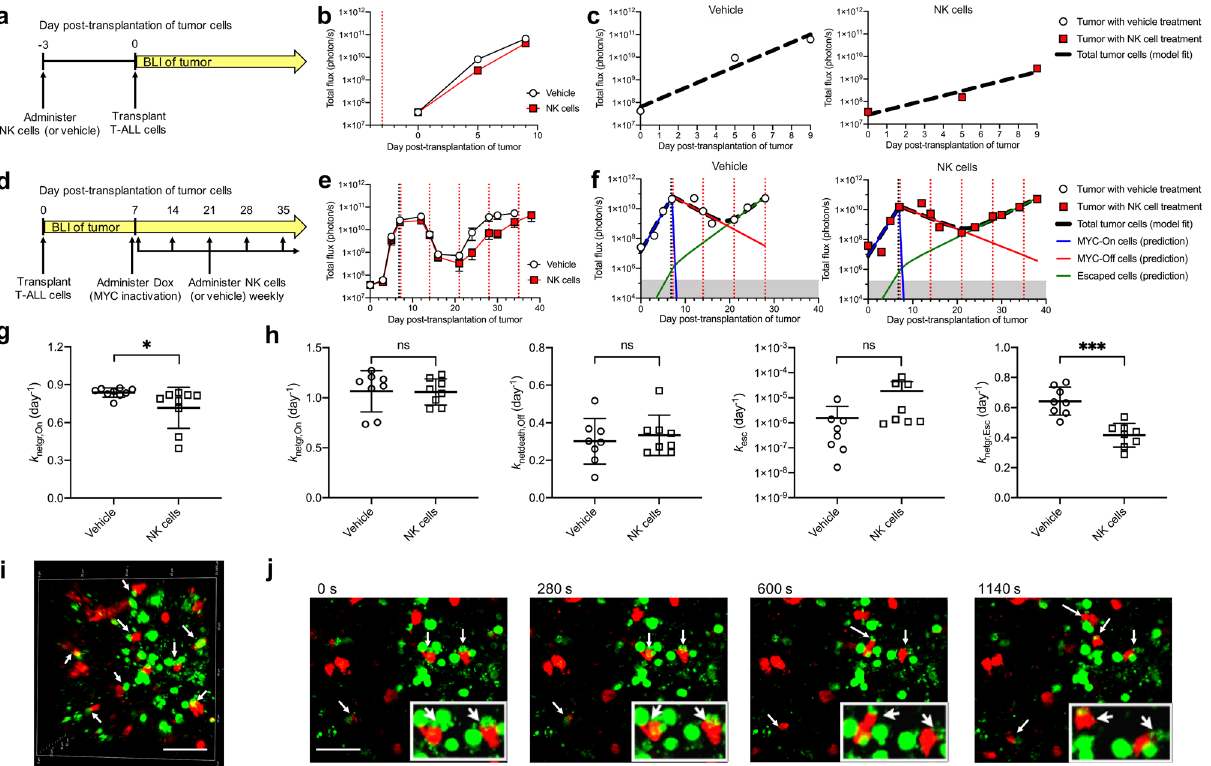
Figure 5. Bioluminescence imaging (BLI) and mathematical modeling analysis showed NK cells delayed ( a – c ) tumor growth and ( d – f ) recurrence. ( a ) NK cells were adoptively transferred 3 days before intravenous T-ALL-FLuc cell transplantation. ( b ) FLuc measurement of tumor burden in mice with or without NK cell transfer (mean ± SEM of n = 9 mice per group). ( c ) Representative growth curve for a mouse without or with NK cell transfer. ( d ) T-ALL-FLuc cells were intravenously transplanted into NSG mice on day 0. On day 7, doxycycline (Dox) was administered. Either NK cells or a saline control were transferred on day 7 and weekly thereafter. ( e ) BLI measurement of tumor burden in mice with or without NK cell transfer (mean ± SEM of n = 8 mice per group). ( f ) Examples of model fits to BLI measurements in representative mice without or with NK cell transfer. The simplified 3-compartment model was fitted (dashed black line) to FLuc data (white circles), shown superimposed with the predicted population of MYC-On cells (blue line), MYC-Off cells (red line), and Escaped cells (green line). Shaded grey region (below 1.60 × 10 5 photon/s) indicates imaging signal is below the limit of detection. ( g ) Comparison of k net,growth,On in mice shown in ( a – c ). *p < 0.05. ( h ) Comparison of the parameter estimates for mice shown in ( d – f ). ***p < 0.0001. ( i – j ) Intravital microscopic imaging showed NK cells (mCherry-labeled, red) attacking T-ALL cells (GFP-labeled, green). ( i ) 3D imaging of interactions of NK cells and tumor cells. ( j ) Time-lapse imaging showed NK cells (red) actively attacking T-ALL cells (green). Zoomed-in images are shown n inset. Interactions of NK cells and tumor cells are indicated by white arrows. Scale bar = 20